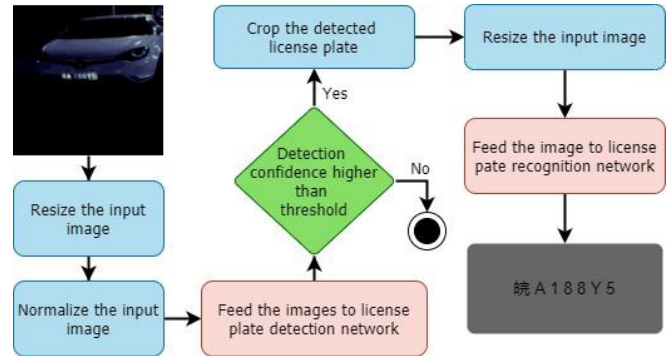
Figure 3. Two-stage license plate recognition